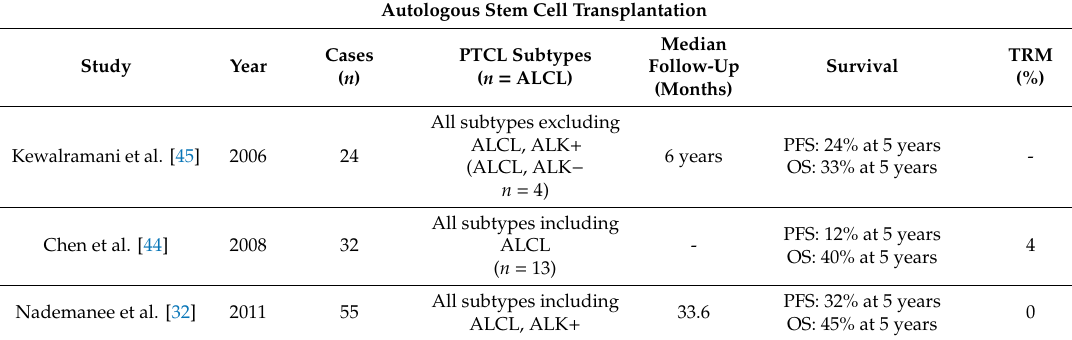
Table 6. Autologous and allogeneic stem cell transplantation in the relapsed and refractory setting: Retrospective